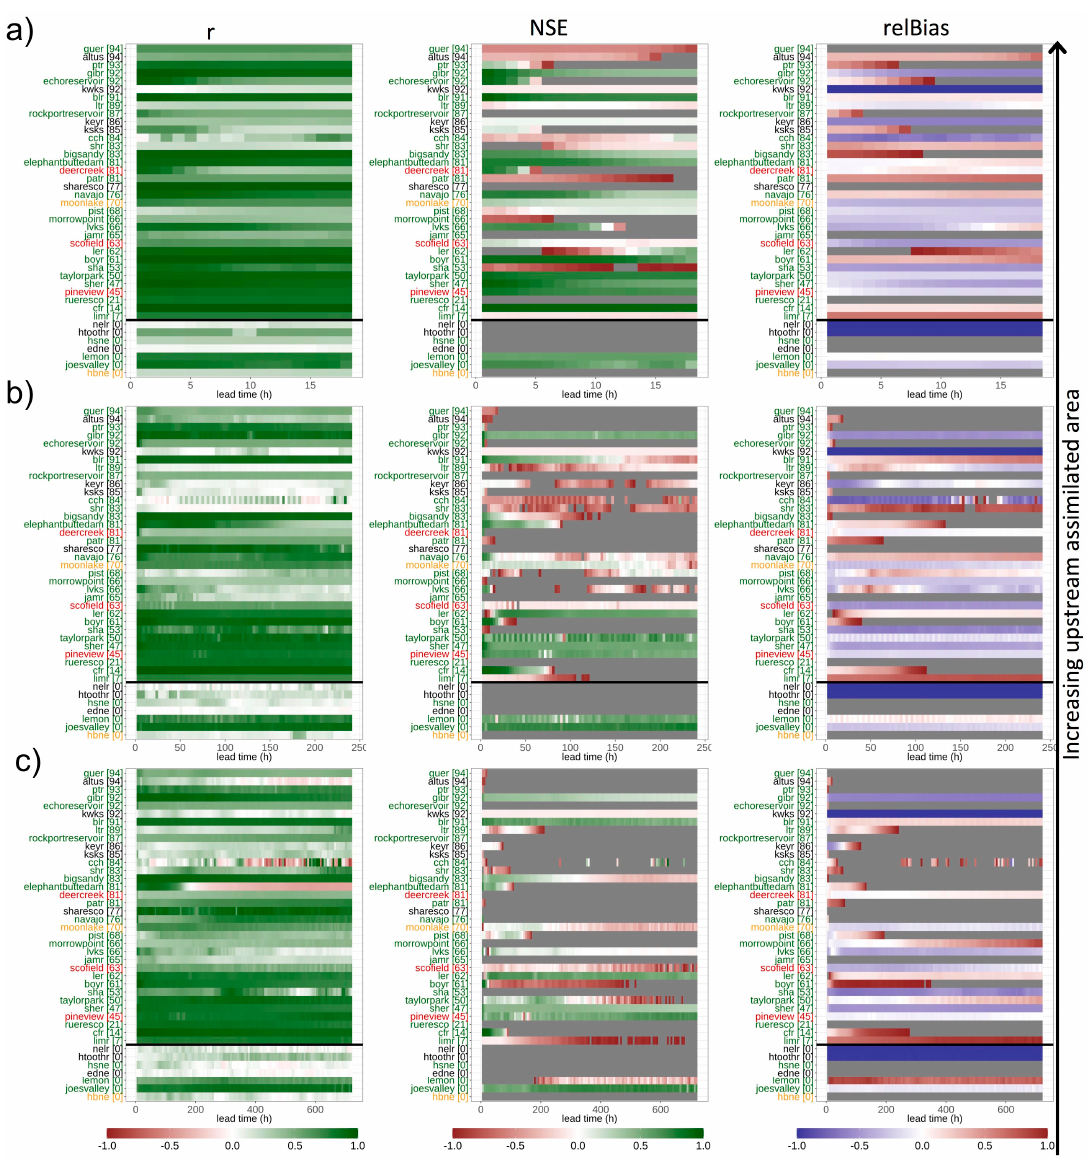
Figure 4. Performance of NWM reservoir inflows across lead times for one year, where reservoirs in each subplot are ordered from bottom to top by the percent of upstream assimilated area (percentages are listed in parenthesis on the y -axis with reservoir name). The black bold line separates reservoirs with no assimilation upstream to the ones that have assimilation upstream. Each column from left to right columns illustrate r , NSE, relBias , where the metric is scaled by color density and grey is out of valid range ( relBias > +1 or relBias < − 1 and NSE < − 1). For r and NSE , green values are higher performance and red is worse; and for relBias , blue is high-biased and red is low-biased. The subplot rows are forecast cycles: short ( a ), medium ( b ), long ( c ).